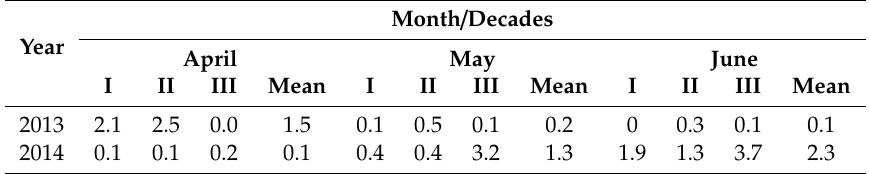
Table 1. Selyaninov hydrothermic coe ffi cient in months during the vegetative seasons of wheat. Month / Decades Year April May June I II III Mean II III Mean Mean